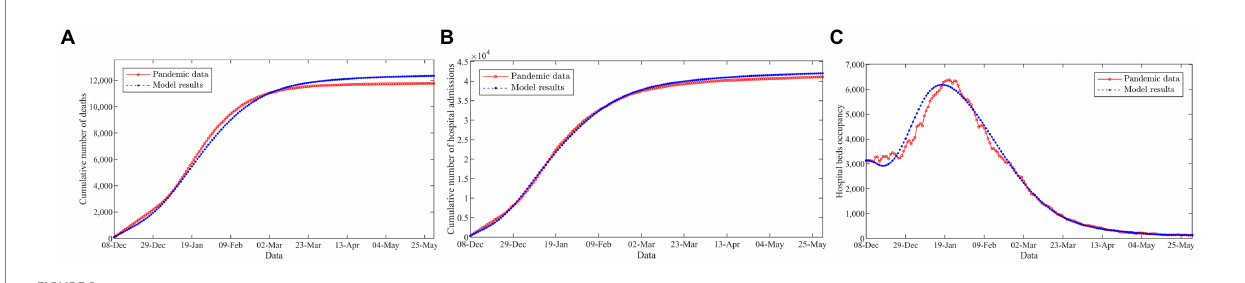
FIGURE 2 Comparison of the officially reported pandemic data and the model results. (A) Cumulative number of deaths. (B) Cumulative number of hospital admissions. (C) Hospital beds occupancy.